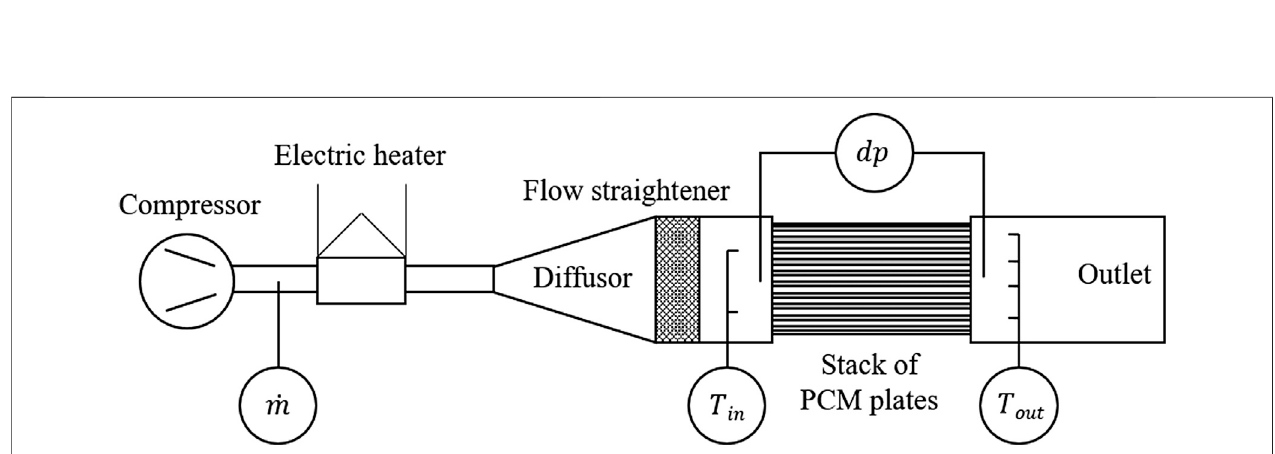
FIGURE3| Conceptualdesignoftheexperimentaltestrig:measureddatainclude fl owrate _ m ,pressuredrop dp ,temperaturesupstream T in anddownstream T out of one stack of plates.